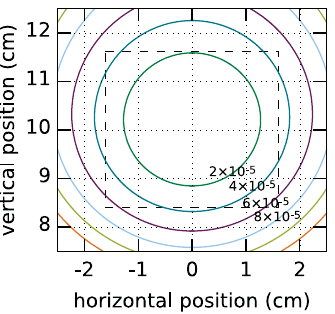
Figure 7. Contour plot of the relative change of the field B 1 = 6 T in the center plane of the selector. The black dashed frame indicates the cross-section of the e − / p +